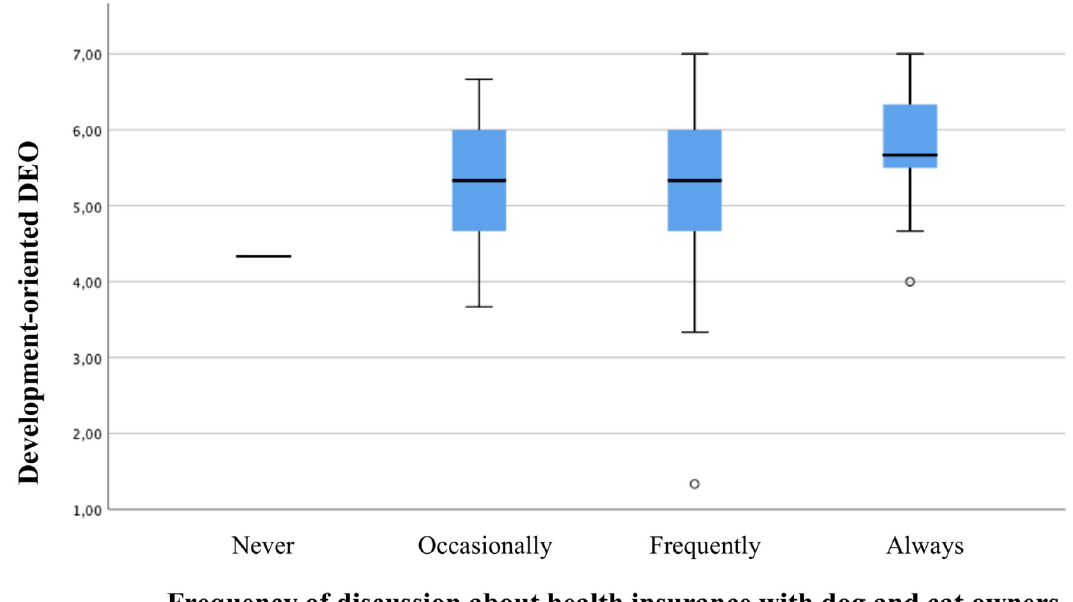
Fig 2. Box plots showing level of development-oriented DEO with respect to frequency of discussion about health insurance for Danish veterinarians. In the box plots, the boundary of the box closest to zero indicates the first quartile, the thick black within the box marks the median, the boundary of the box farthest from zero indicates the third quartile. Whiskers above and below the box indicate 10th and 90th percentiles. Points below the whiskers indicate outliers outside the 10th and 90th percentiles.